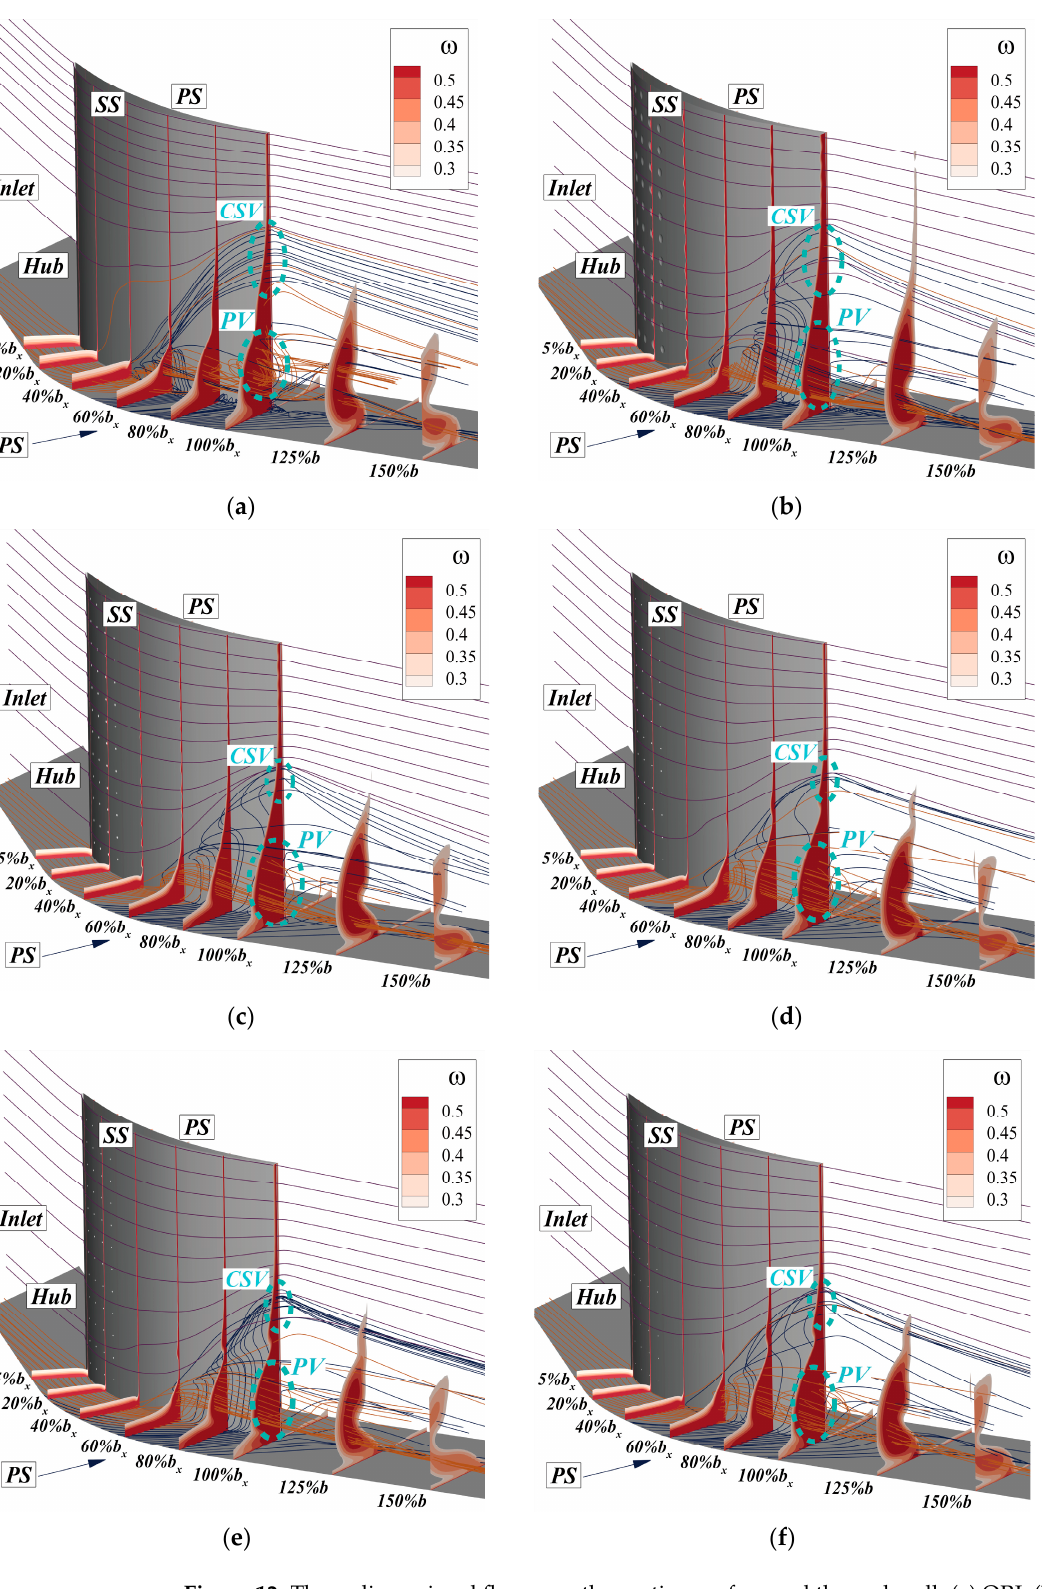
Figure 12. Three-dimensional flow near the suction surface and the end wall. ( a ) ORI; ( b ) 𝜆 = 0.125 ; ( c ) 𝜆 = 0.375 ; ( d ) 𝜆 = 0.5 ; ( e ) 𝜆 = 0.625 ; ( f ) 𝜆 = 0.875 .